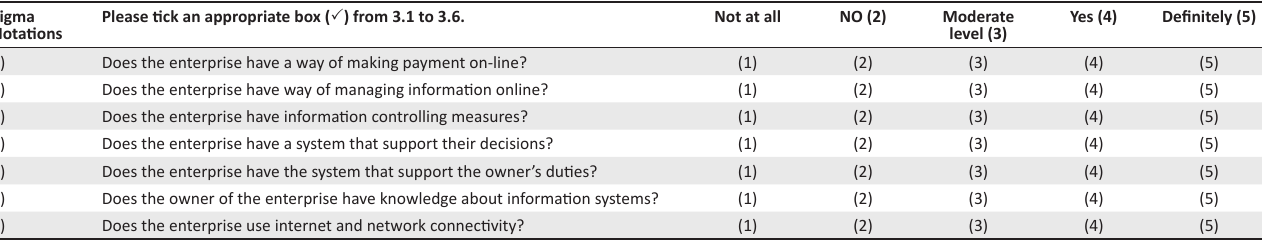
TABLE 1-A1: Please indicate your agreement with the following statements about the information System Components of your enterprise for new information systems such as Enterprise Application Architecture * (See bottom page). Sigma Notations